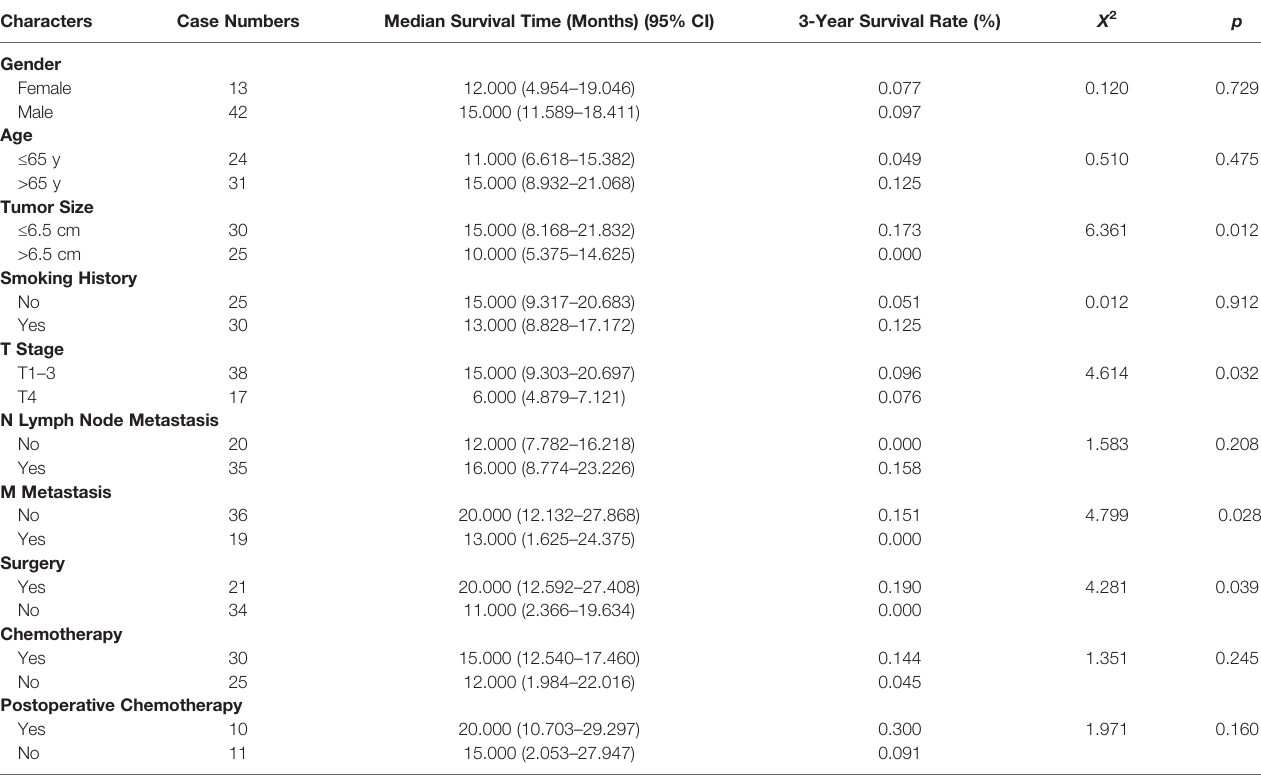
TABLE 1 | Clinicopathological Characteristics and Survival Analysis of 55 Patients with Pulmonary Sarcomatoid Carcinoma (PSC).